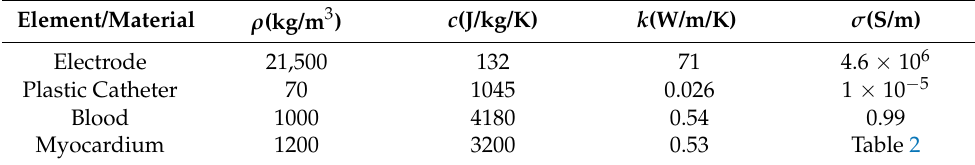
Table 1. The electrical and thermal properties of the ablation model [21,33].